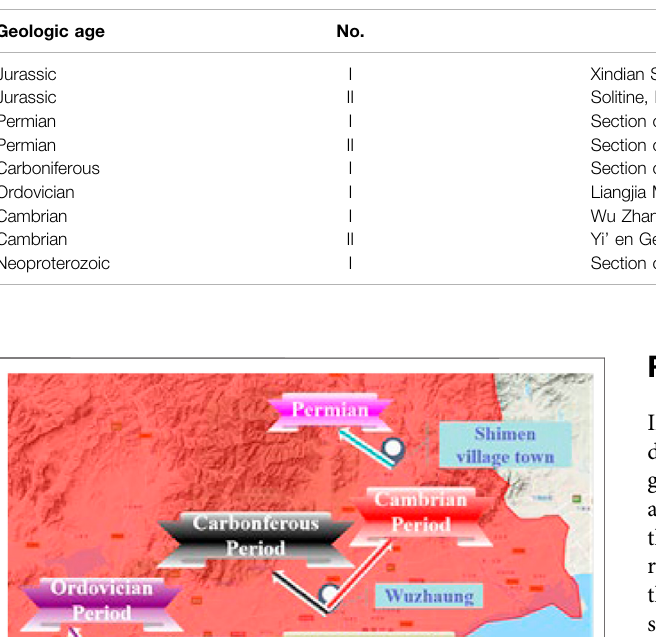
Frontiers in Physics |